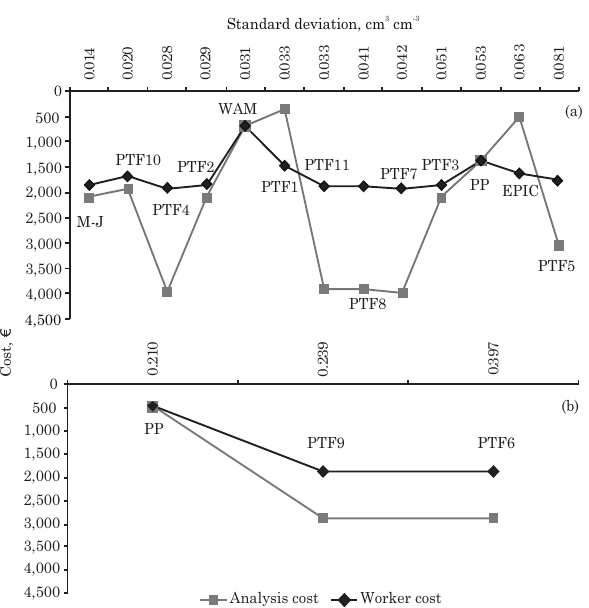
Figure 2. Relation between cost of information and uncertainty in the determination/estimation of hydro-physical limits, (a) PWP and (b) FC. WAM: Water activity meter used for PWP estimation, PP: pressure plate, PTF i : pedotransfer functions, M-J: Mayr-Jarvis